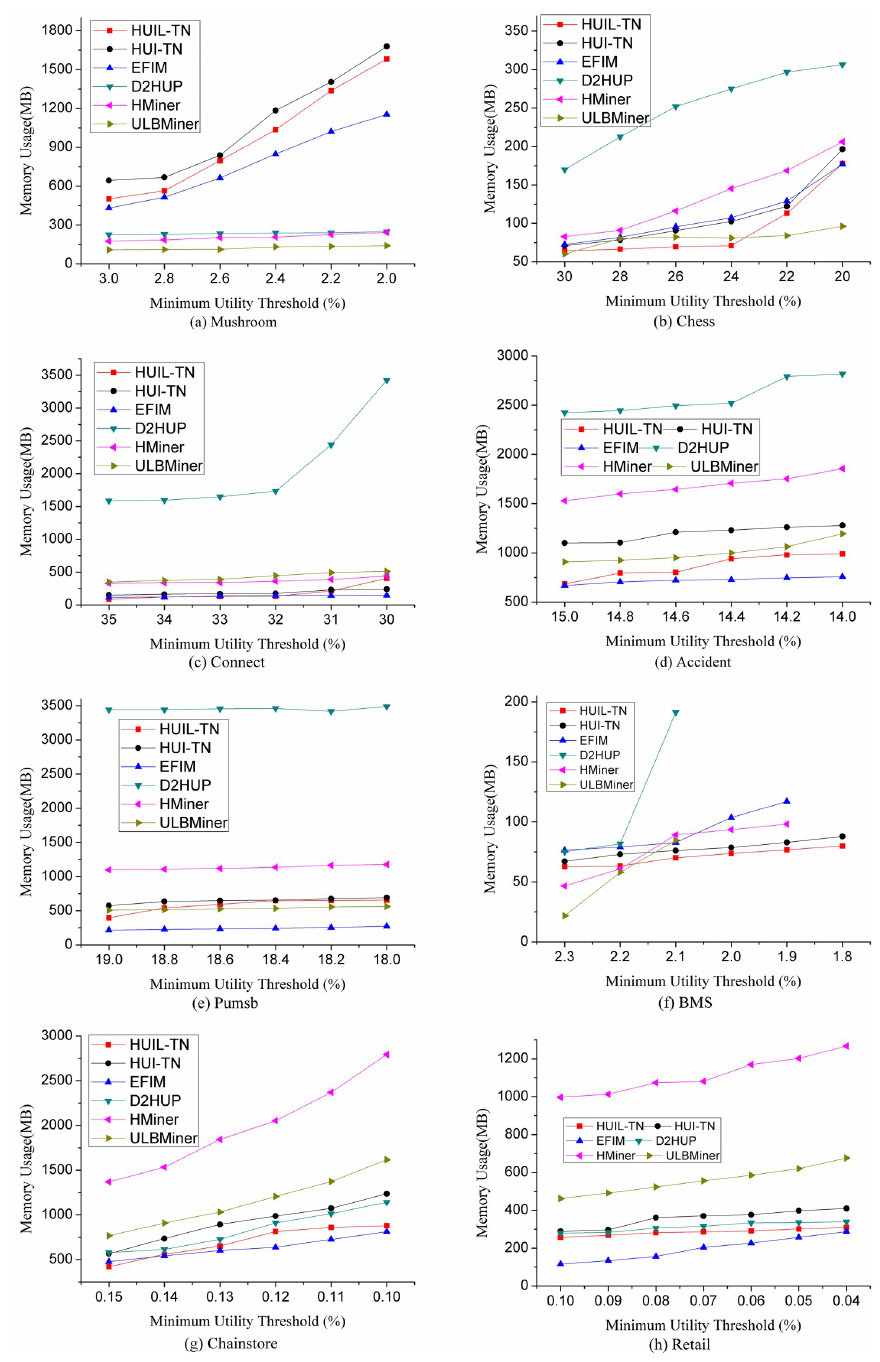
Fig 8. Comparison of memory